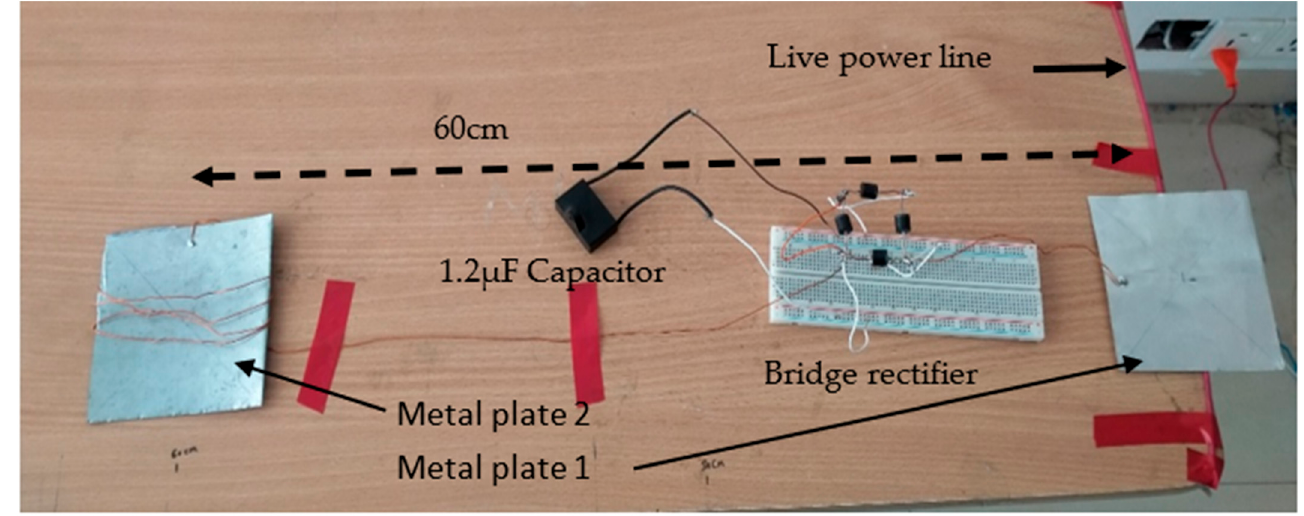
Figure 8 . The experimental setup for buildup of voltage in the 1.2 μ F capacitor ( C 0 ).